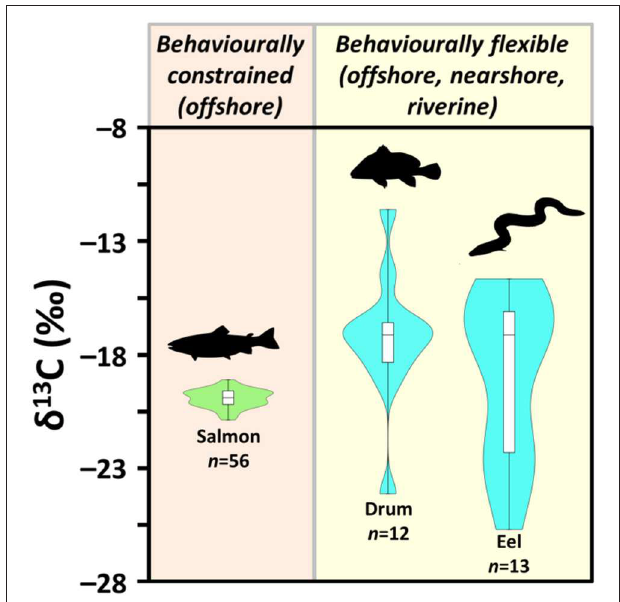
FIGURE 4 | Violin and box plot of δ 13 C for fish : freshwater resident Atlantic salmon ( Salmo salar ), freshwater drum ( Aplodinotus grunniens ), and American eel ( Anguilla rostrata )—from archaeological sites (1000–1800 CE) near Lake Ontario (data from van der Merwe et al., 2003; Guiry et al., 2016b; Hammersley, 2016; see Electronic Supplementary Information 1